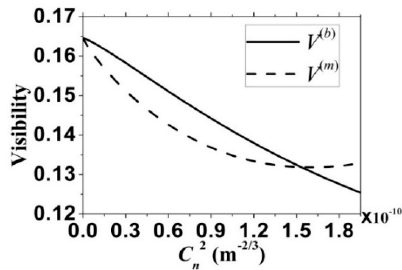
Figure 3. Visibility of lensless ghost image versus structure constant in monostatic turbulence (solid line) and in bistatic turbulence (dashed line).